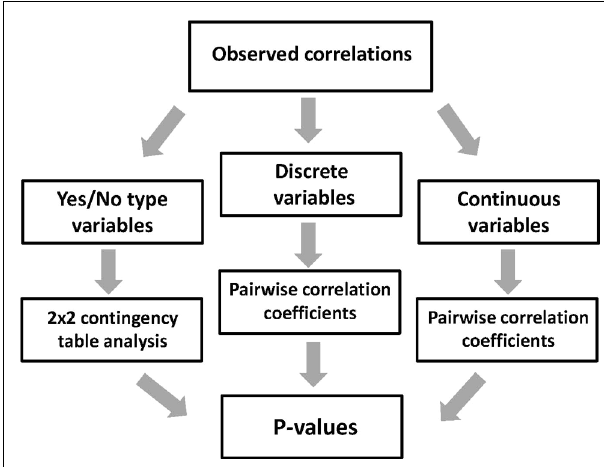
FIGURE 5 | Evaluation of statistical significance of the observed correlations. Method for statistical evaluation of correlation data is chosen according to the type of analyzed protein features (variables).The three types of the features processed by this analysis include yes/no, discrete, and continuous variables.